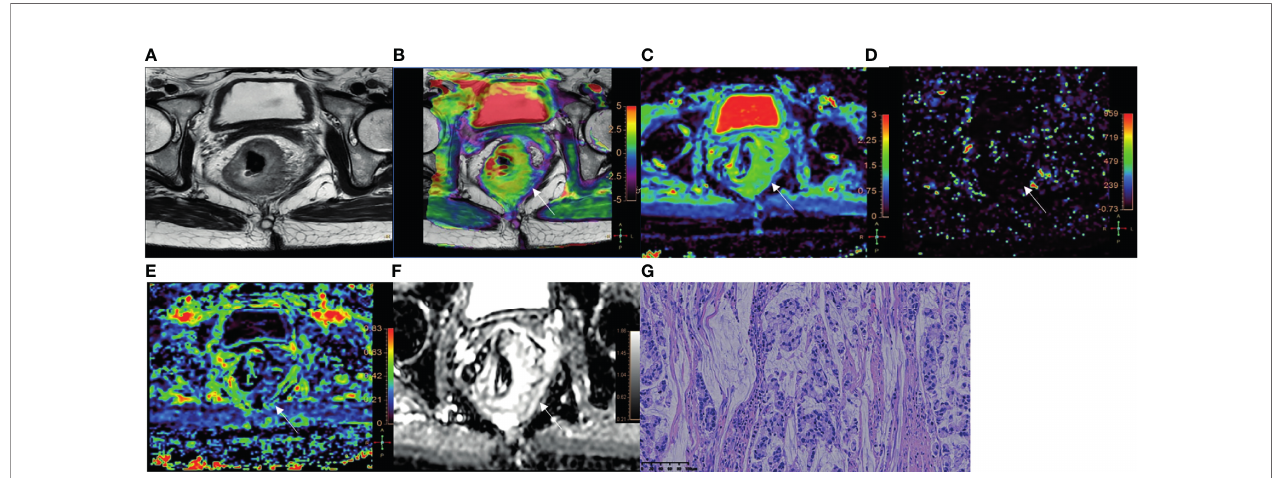
FIGURE 2 | A 51-year-old female with MC. (A) Oblique axial T 2 -weighted image showed a mass with high intensity in the rectum. (B) APT-T2 merged image showed the mass with a mean APT SI of 3.4%. (C – E) D, D* and f maps showed the mass with values of 1.42×10 -3 mm 2 /s, 5.00×10 -3 mm 2 /s and 0.22, respectively. (F) The mass showed high intensity (1.87×10 -3 mm 2 /s) on the ADC map. (G) HE staining revealed mucinous adenocarcinoma. (×200).